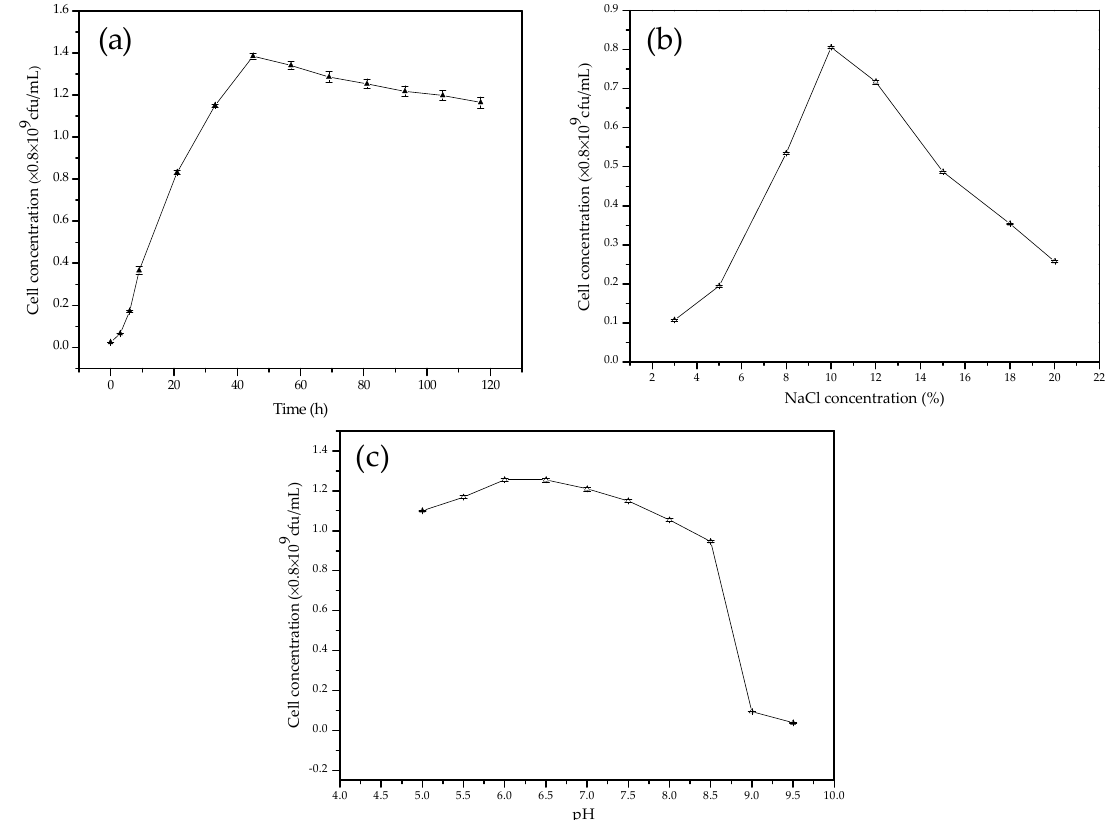
Figure 3. Characterization of LD532 bacteria: ( a ) growth curve; ( b ) cell concentration of LD532 bacteria after the 24 h cultivation at different NaCl concentrations; and ( c ) cell concentration of LD532 bacteria after the 24 h cultivation at different pH values.